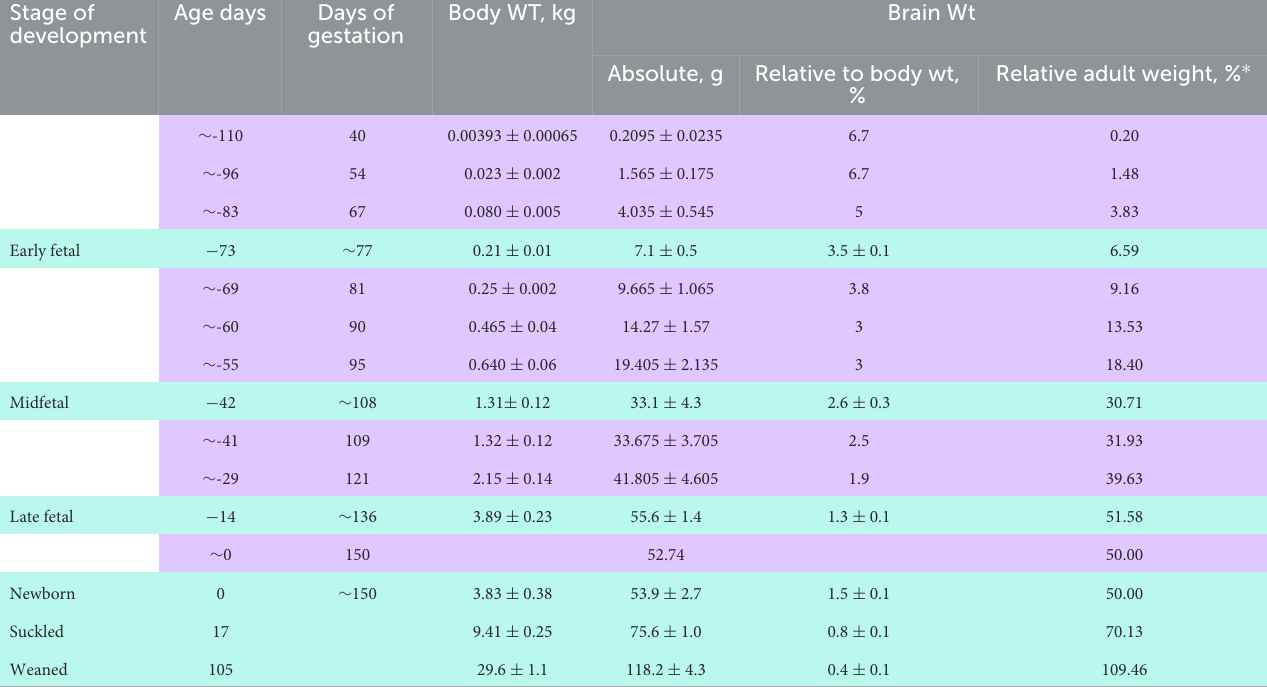
TABLE 1 Embryonic and postnatal growth stages in relation to body weight gain, brain weight (absolute and relative to body). Stage of development